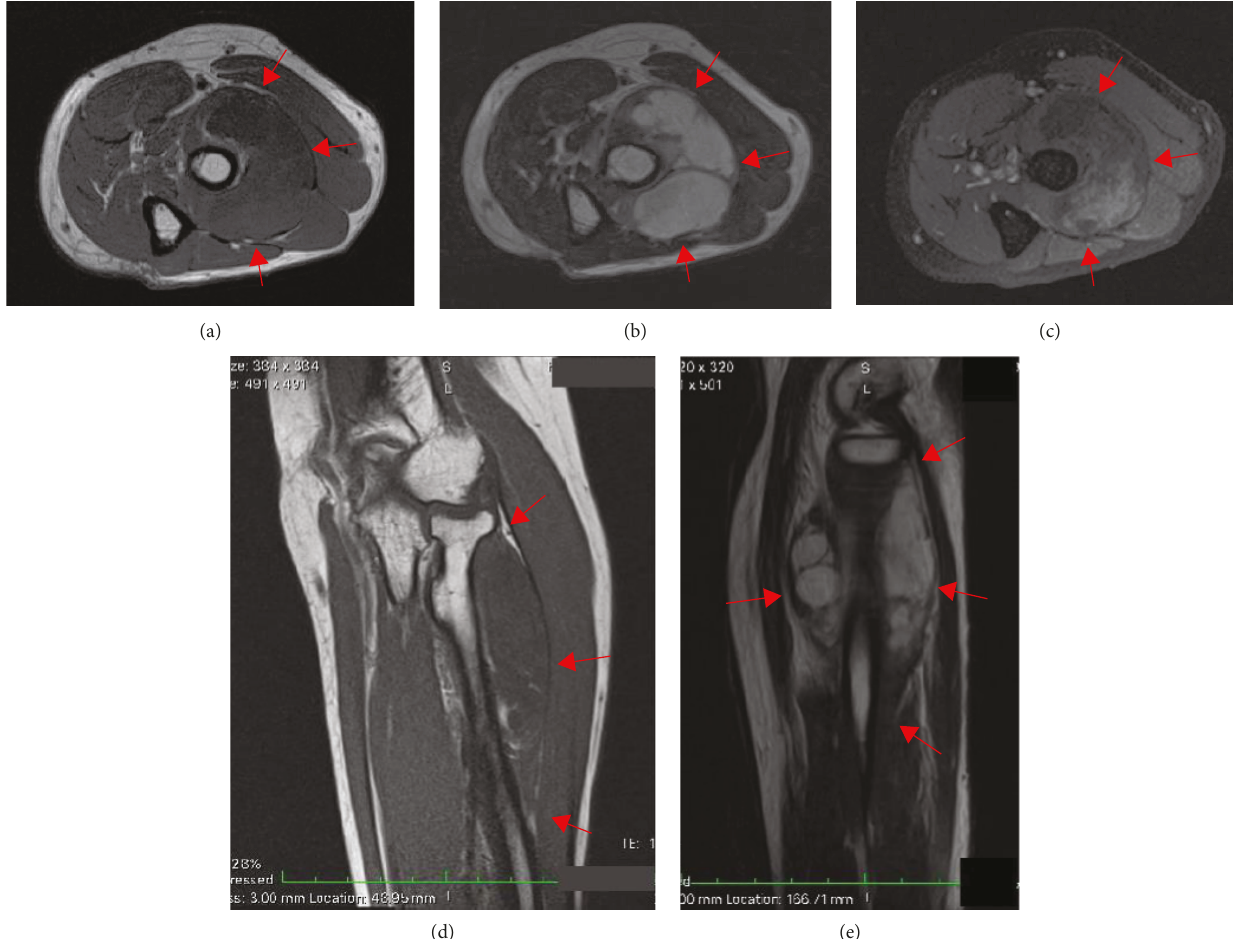
Figure 1: Magnetic resonance imaging (MRI) showed a lobulated multiseptated lesion seen within left supinator muscle as delineated by the red arrows, which showed a hyperintense signal on T2-weighted images (T2WI) (b, e) and hypointense on T1-weighted images (T1WI) (a, d), with peripheral enhancement post contrast